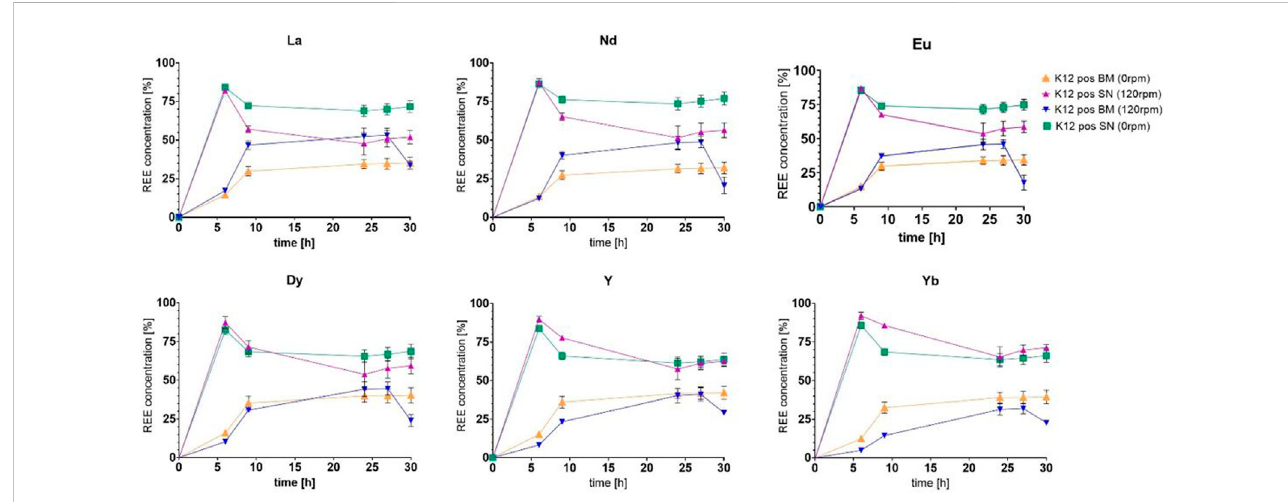
FIGURE 5 Comparison oftheuptakeofsixchosenelements astherepresentation ofthefullsetoflanthanides (concentrationsgiven asapercentage of2.25 ppm).